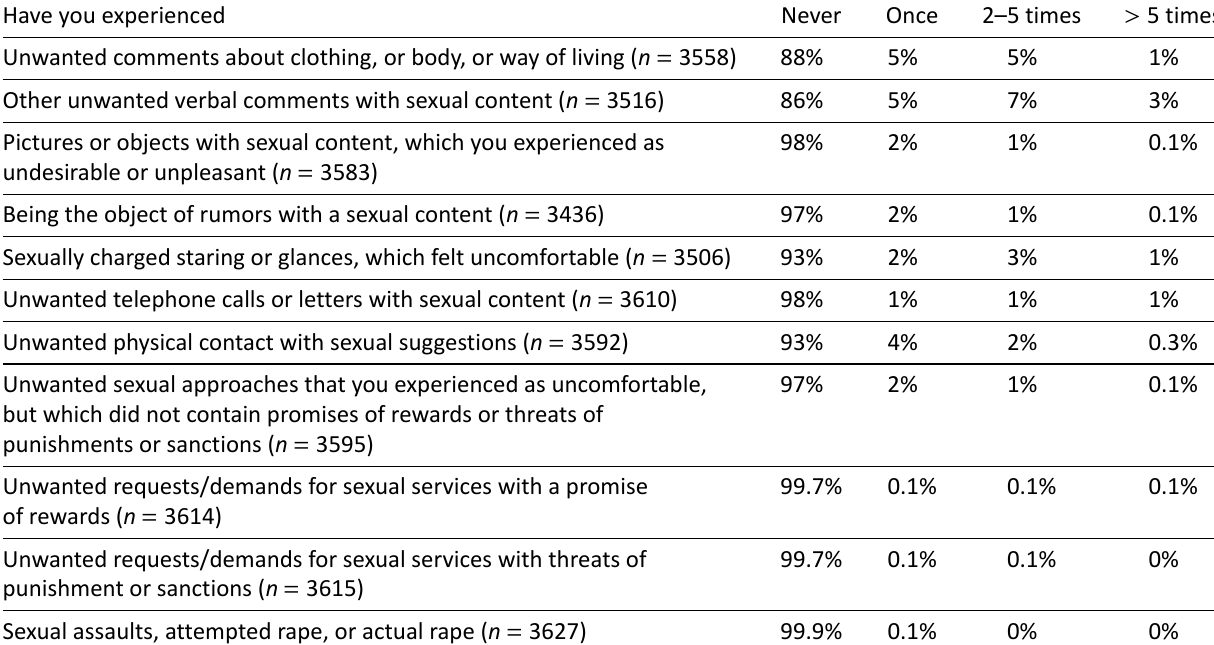
Table 3. Frequency of UA in last six months (split on 11 items).